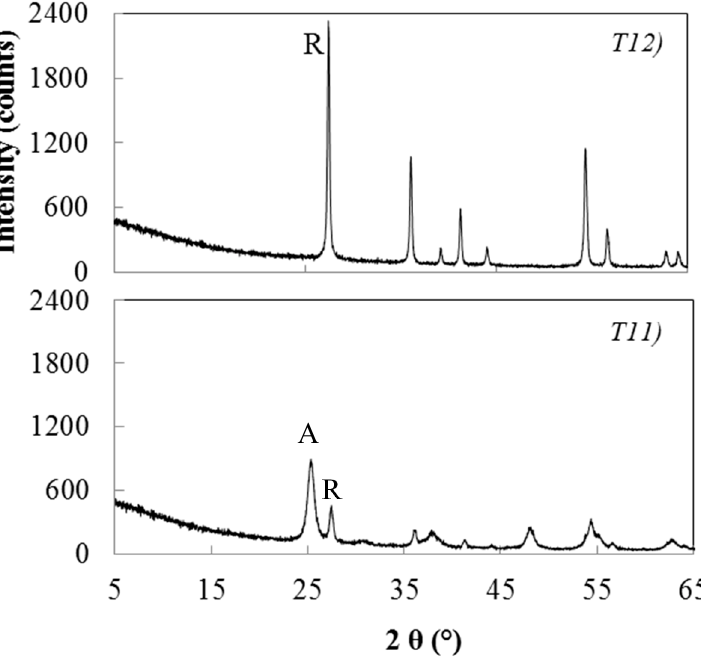
Figure 9. XRD patterns of sample T11 and T12. (A = anatase; R = rutile).